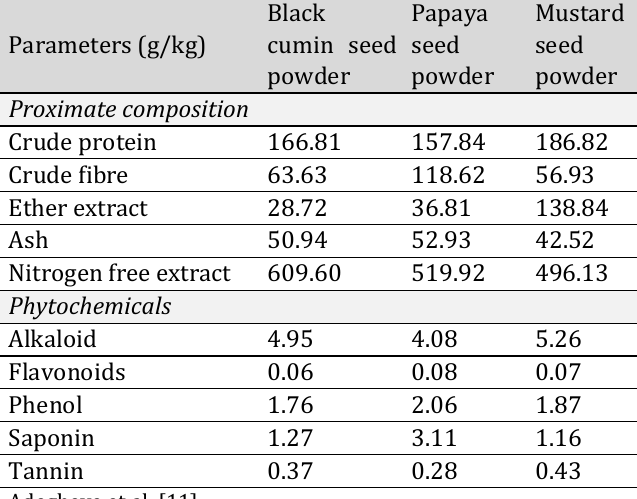
Table 1. The proximate composition and phytochemicals of mustard, papaya, and black cumin seed powders.